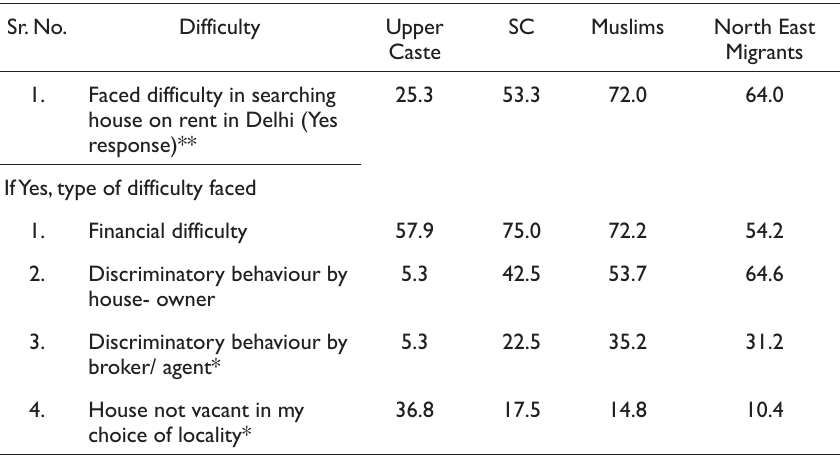
Table 12. Nature of Difficulties in Rental Housing Market Sr.